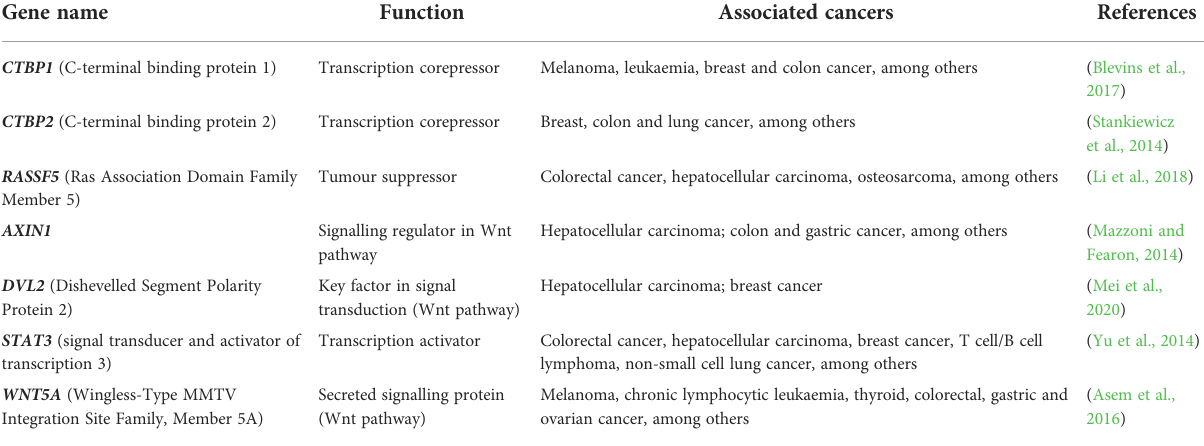
TABLE 2 Cancer pathway ’ s genes, associated with altered CpG sites methylation upon infection with L. donovani